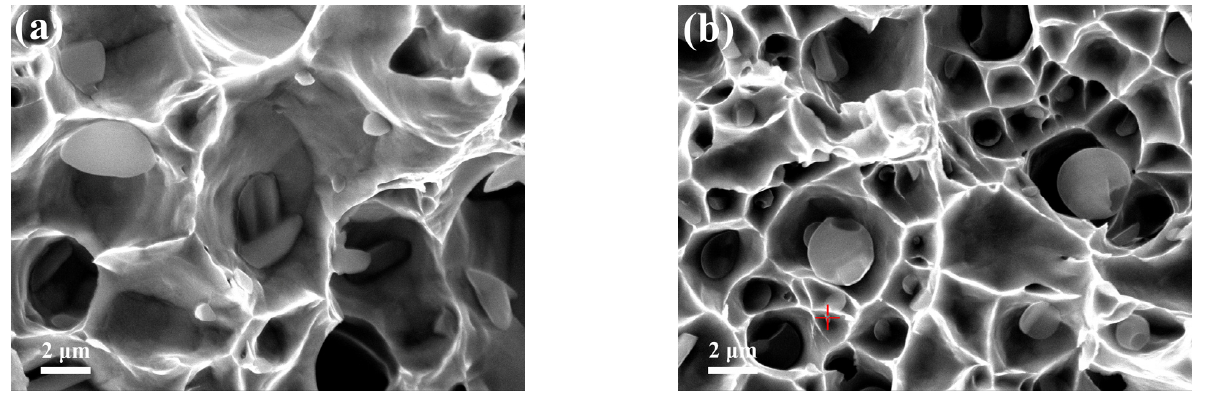
Figure 14. ( a ) Tensile fracture morphology of 1280-S1 ODS steels; ( b ) Tensile fracture morphology of 1280-S3 ODS steels.